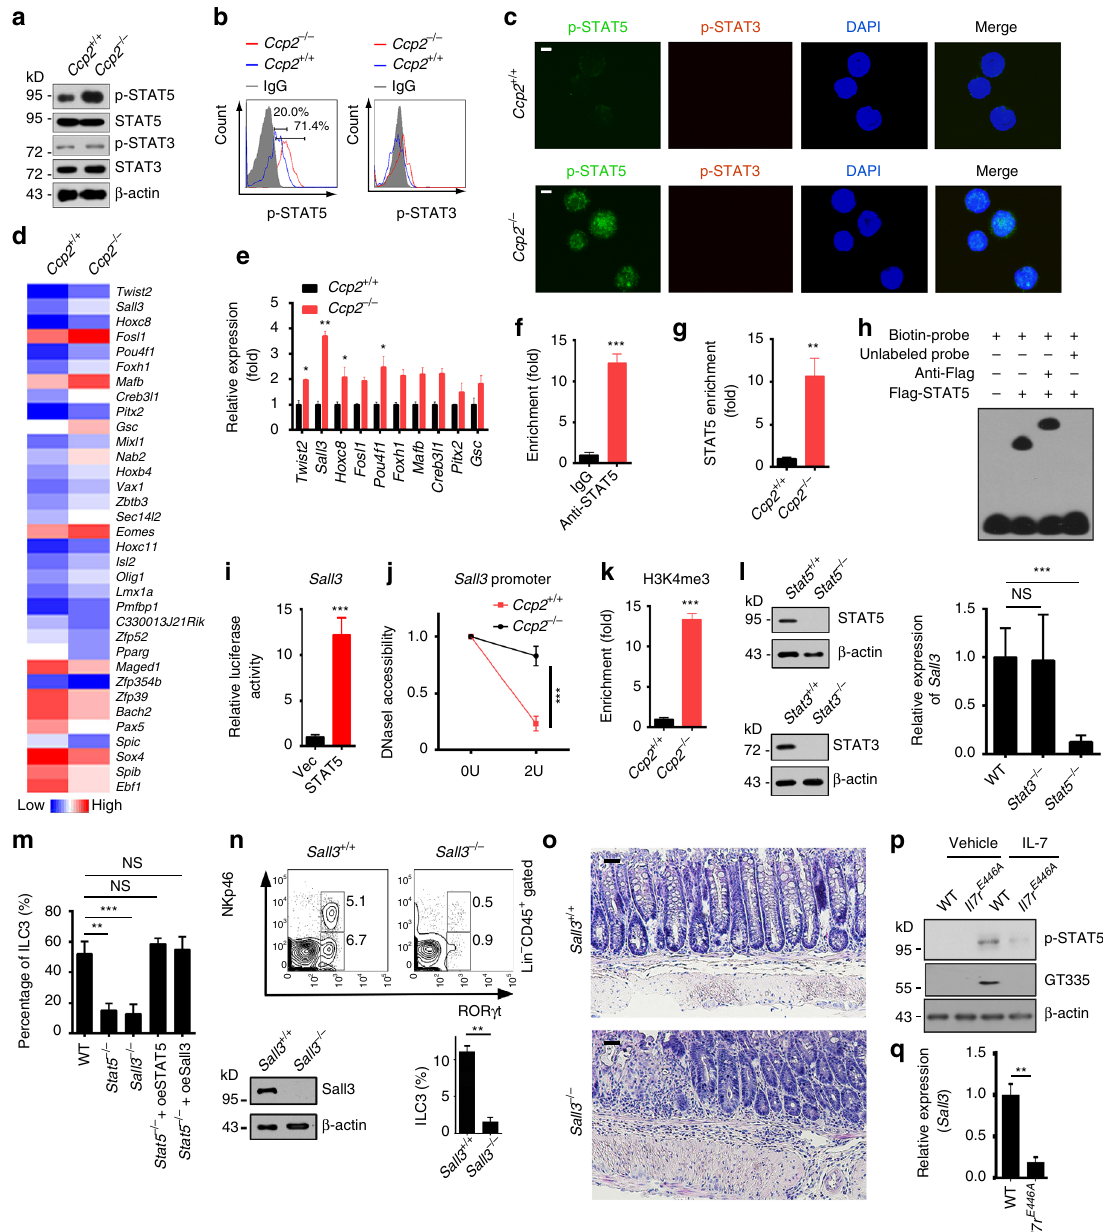
Fig. 5 IL-7R α glutamylation promotes Sall3 expression by STAT5. a – c Phosphorylation of STAT3 and STAT5 was tested by western blotting a , fl ow cytometry b and immuno fl uorescence staining c in CHILPs from WT and Ccp2 − / − mice after IL-7 stimulation. p-STAT5, green ; p-STAT3, red ; nucleus, blue . d Heat map of representative gene expression values from microarray data. In all, 1 × 10 6 CHILPs (Lin − Flt3 − CD25 − IL-7R α + α 4 β 7 + ) from Ccp2 +/+ or Ccp2 − / − mice were sorted for microarray. e Analysis of indicated gene expression levels in Ccp2 +/+ and Ccp2 − / − CHILPs by quantitative reverse transcription PCR (RT-qPCR). Relative fold changes of gene expression values were normalized to endogenous Actb . f , g Enrichment assessment of STAT5 on Sall3 promoter in CHILPs from Ccp2 +/+ and Ccp2 − / − mice. h The association of STAT5 with Sall3 promoter was examined by EMSA. Sall3 promoter probe was biotin-labeled. i Flag-STAT5, pTK, and pGL3- Sall3 promoter were transfected into 293T cells for luciferase assay. j DNaseI accessibility of Sall3 promoter in CHILPs from Ccp2 +/+ and Ccp2 − / − mice was assessed. k H3K4me3 enrichment on Sall3 promoter was determined. CHILPs were isolated from Ccp2 +/+ and Ccp2 − / − mice, followed by ChIP assay. l Sall3 mRNA levels were detected in WT, Stat3 − / − , and Stat5 − / − CHILPs. m CHILPs were isolated from WT mice and cultured with mitomycin C-treated OP9 cells for in vitro differentiation assay. Stat5 − / − CHILPs were transfected with STAT5 or Sall3 overexpression plasmid. Percentages of ILC3s were analyzed by fl ow cytometry. oe overexpression. n ILC3s were analyzed in Sall3 +/+ and Sall3 − / − mice. n = 6 for each group. o Histology of colons from Sall3 +/+ and Sall3 − / − mice 8 days after C. rodentium infection. Scale bars , 50 μ m. p IL-7R α glutamylation and STAT5 phosphorylation in CHILPs in the absence or presence of IL-7. CHILPs from WT or Il7r E446A BM were incubated with IL-7 and vehicle, followed by immunoblotting. β -actin was probed as loading controls. q Sall3 expression levels were tested in WT and Il7r E446A CHILPs by RT-qPCR. Relative fold change of Sall3 expression values were normalized to endogenous Actb . ** P < 0.01, *** P < 0.001 (Student ’ s t -test). Data represent three independent experiments. Error bars in e – g , i – n , and q indicate